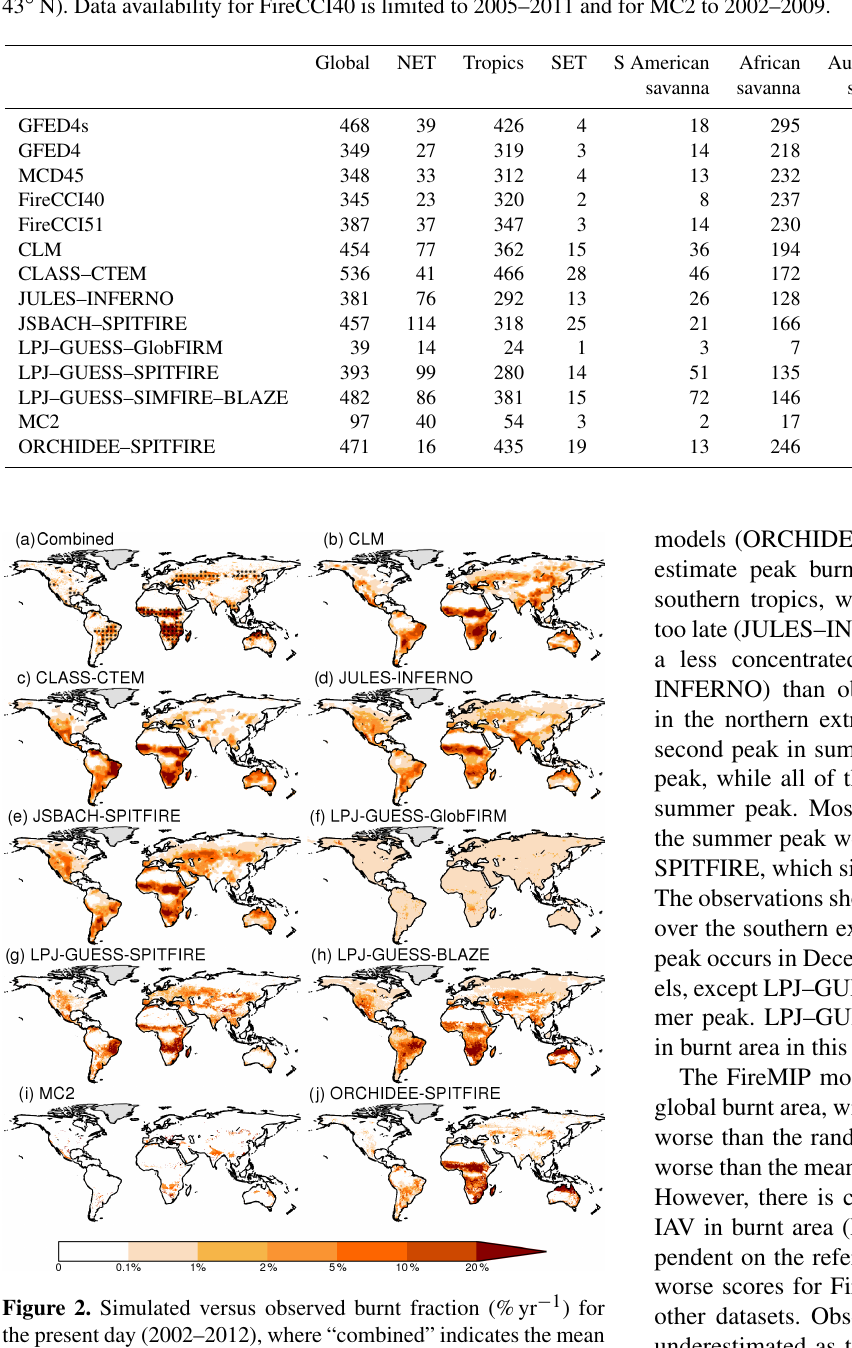
Table 2. Simulated and observed burnt area (Mha) for the period 2002–2012 for the globe and for key regions including the northern extratropics (NET; >30 ◦ N), the southern extratropics (SET; > 30 ◦ S), the tropics (30 ◦ N–30 ◦ S), the savanna regions of Africa (18 ◦ W–40 ◦ E,